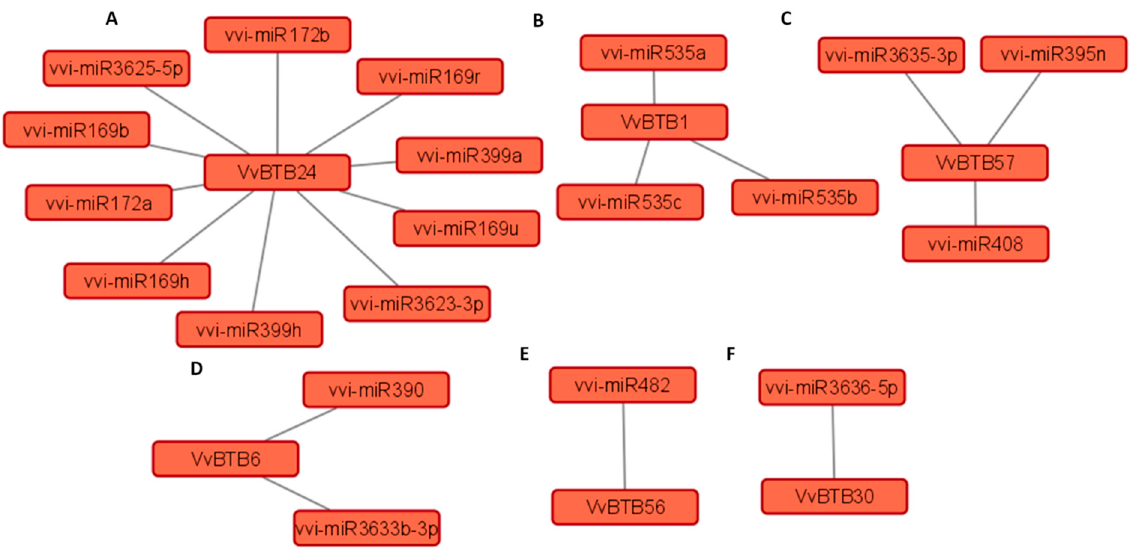
Figure 7. Interaction analysis of BTB genes, including ( A ) VvBTB24 , ( B ) VvBTB1 , ( C ) VvBTB57 , ( D ) VvBTB6 , ( E ) VvBTB56 and ( F ) VvBTB30 with V. vinifera miRNAs. Each interaction network was generated using Cytoscape 3.9 software.